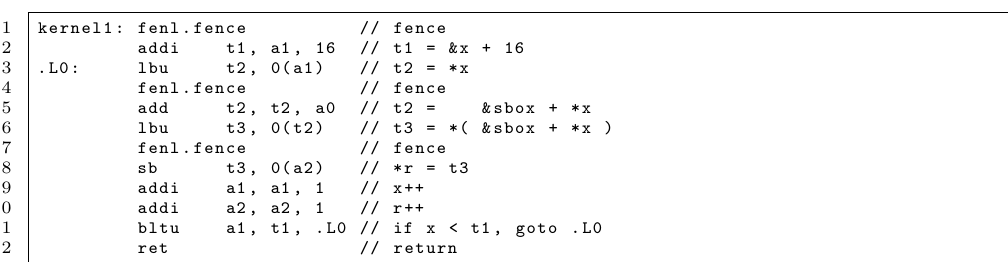
Figure 4: Target kernel for experiment 1: masked AES SubBytes (assuming pre- computation of a masked S-box). Note that the kernel is described post -insertion of fence instructions; the original, pre -insertion version can be inferred by ignoring said instructions (i.e., lines 1, 4, and